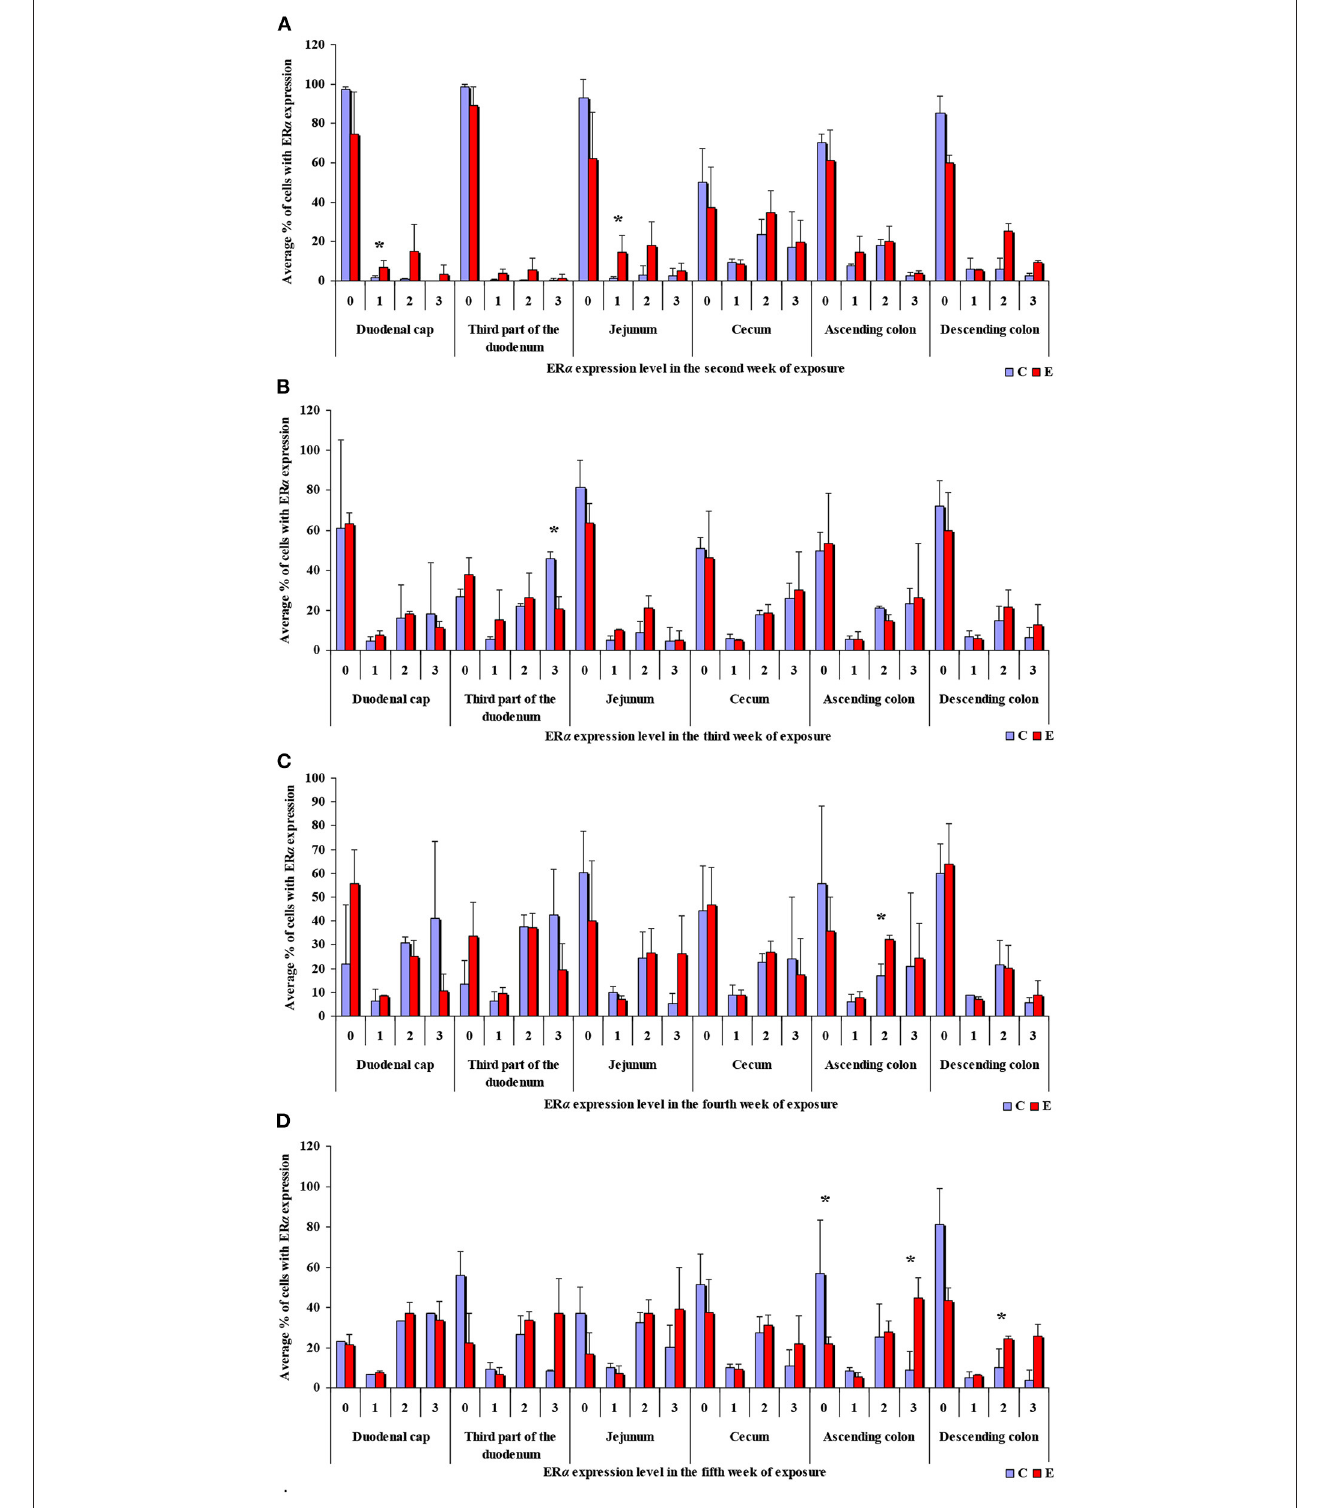
FIGURE 3 | Immunohistochemical expression of ER α (graded on a 4-point scale: negative = 0 points; weak and homogeneous = 1 point; mild or moderate and homogeneous = 2 points; intense or strong and homogeneous = 3 points) in different intestinal segments in selected weeks of exposure: (A) in week II; (B) in week III; (C) in week IV; (D) in week V. ER α expression was presented as mean values ( ± ) and standard deviation (SD) for each sample. * P ≤ 0.05 were compared with the control group.